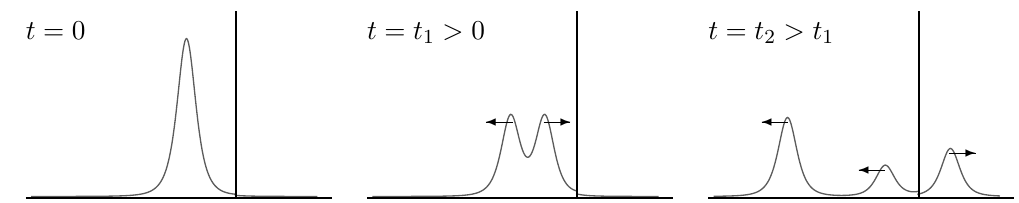
Figure 5 . Three snapshots in the time evolution of a state created by acting with a local operator on the vacuum at t = 0, at some position on the left of the interface, with a (cid:12)nite shift in imaginary time. The curves show the expectation value of the energy density. The pictures are obtained using a two-particle state in the free boson example of subsection